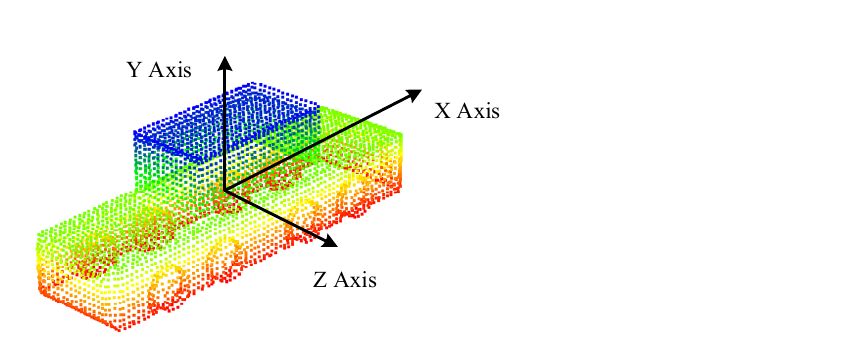
Figure 5. Target vehicle point cloud template aligned with the origin of the global coordinate system, which was elaborated on in detail in Section 4.1.1.